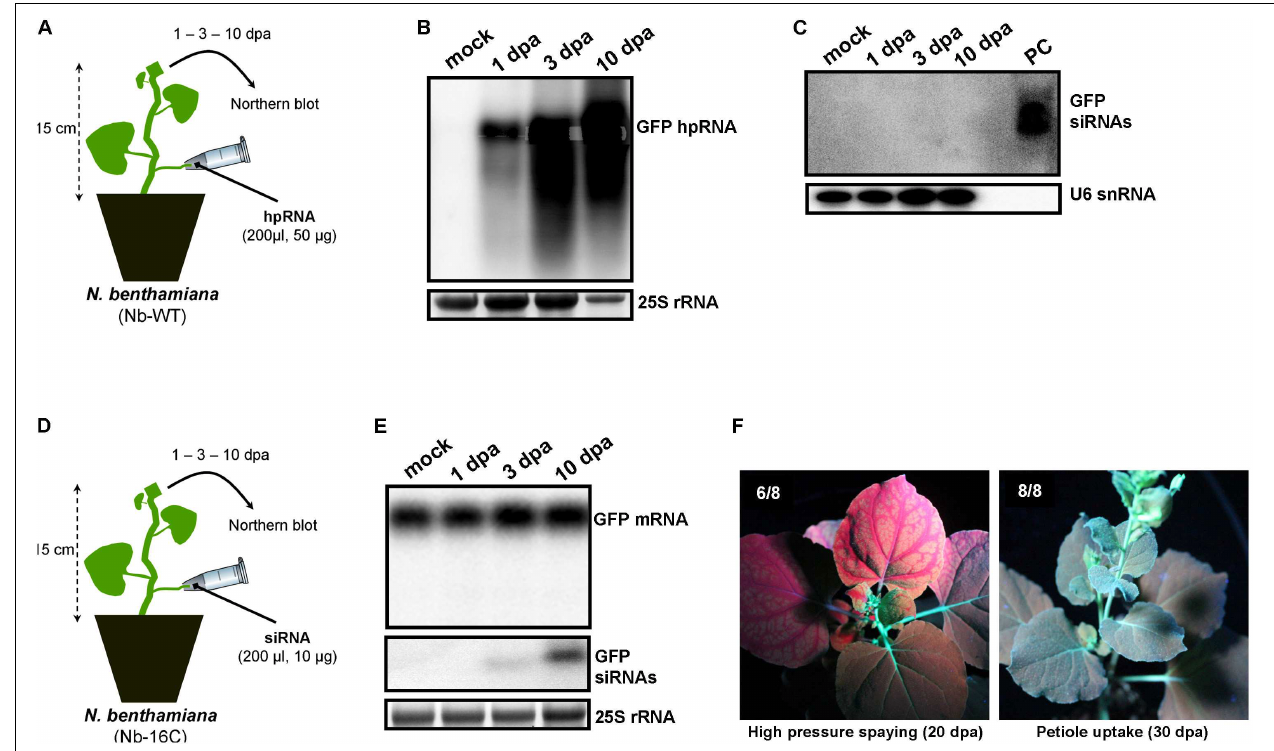
FIGURE 4 | Delivery of exogenous hpRNA (500 nt) and siRNA (22 nt) in N. benthamiana wild type (Nb-WT) and GFP-expressing (Nb-16C) by petiole absorption. (A) Apical Nb-WT leaves were harvested 1, 3, and 10 dpa and total RNA was extracted. (B) Northern blot for the detection of GFP hpRNA in Nb-WT. Total RNA (5 µ g) was analyzed in a 1.2% agarose/formaldehyde gel and the full-length GFP cDNA fragment (792 bp) was used as a hybridization probe. The ethidium bromide stained gel depicts the 25S rRNA band and serves as an RNA loading control. (C) Northern blot for the detection of GFP siRNAs in Nb-WT. Total RNA (20 µ g) was analyzed in a 15% polyacrylamide gel and the full-length GFP cDNA fragment (792 bp) was used as a hybridization probe. As positive control (PC) in vitro synthesized 22-nt GFP siRNAs (100 ng) were included. Hybridization of the membrane with a DNA oligo detecting the U6 snRNA served as an RNA loading control. (D) Apical Nb-16C leaves were harvested 1, 3, and 10 dpa and total RNA was extracted. (E) Northern blot for the detection of GFP mRNA (upper panel) and GFP siRNAs (middle panel) in Nb-16C upon the petiole-mediated uptake of a 22-nt GFP siRNA. For the detection of GFP mRNA, total RNA (5 µ g) was analyzed in a 1.2% agarose/formaldehyde gel and for the detection of GFP siRNAs total RNA (20 µ g) was analyzed in a 15% polyacrylamide gel. The full-length GFP cDNA fragment (792 bp) was used as a hybridization probe. The ethidium bromide stained gel depicts the 25S rRNA band and serves as an RNA loading